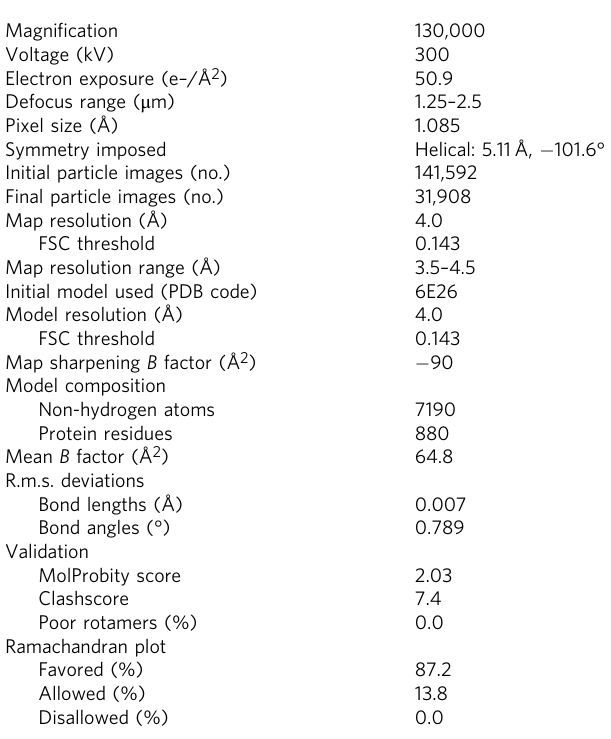
Table 2 Structural statistics for the CARD9 CARD helical assembly Magni fi